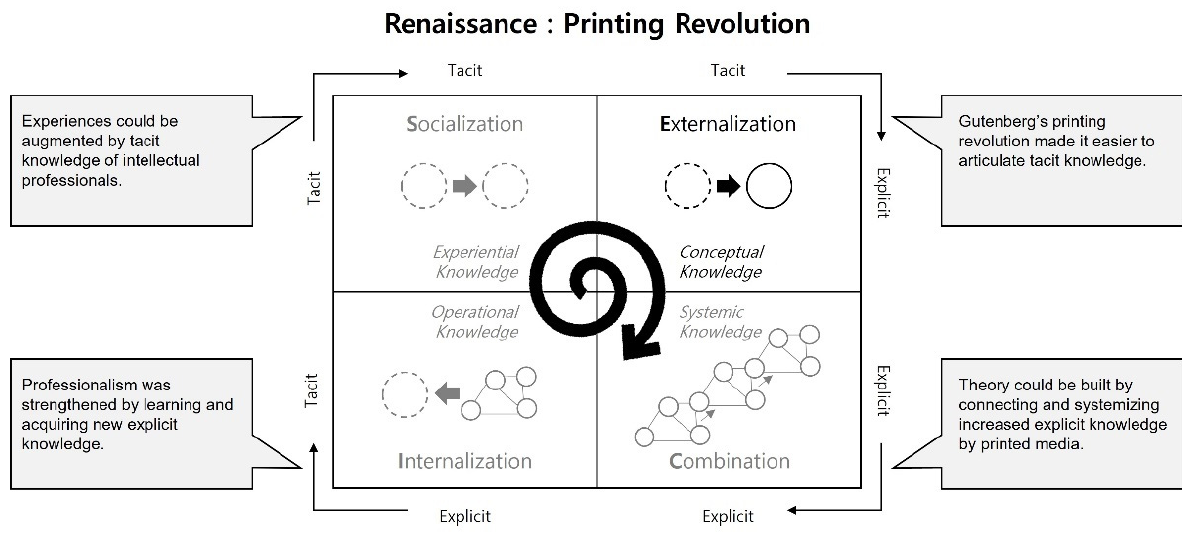
Figure 5. SECI model of the renaissance.